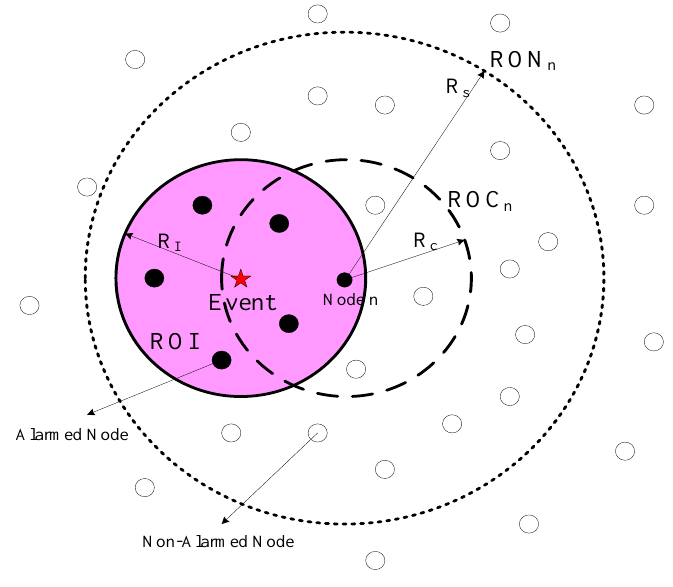
Figure 1. The scenario of various regions used in this